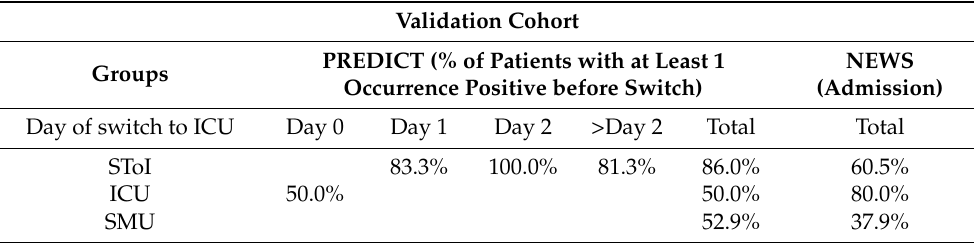
Table 11. Percentages of patients that have at least one positive occurrence for PREDICT score before their switch day (calculated at day 0 for ICU group, day 0 and day 1 for patients who switch after 1 day of hospitalization in SToI group, day 0 and day 1 and day 2 for patients who switch after at least 2 days of hospitalization in SToI group). Line SMU represent the percentage of patient with a positive score at least one time (day 0 and day 1 and day 2) in SMU